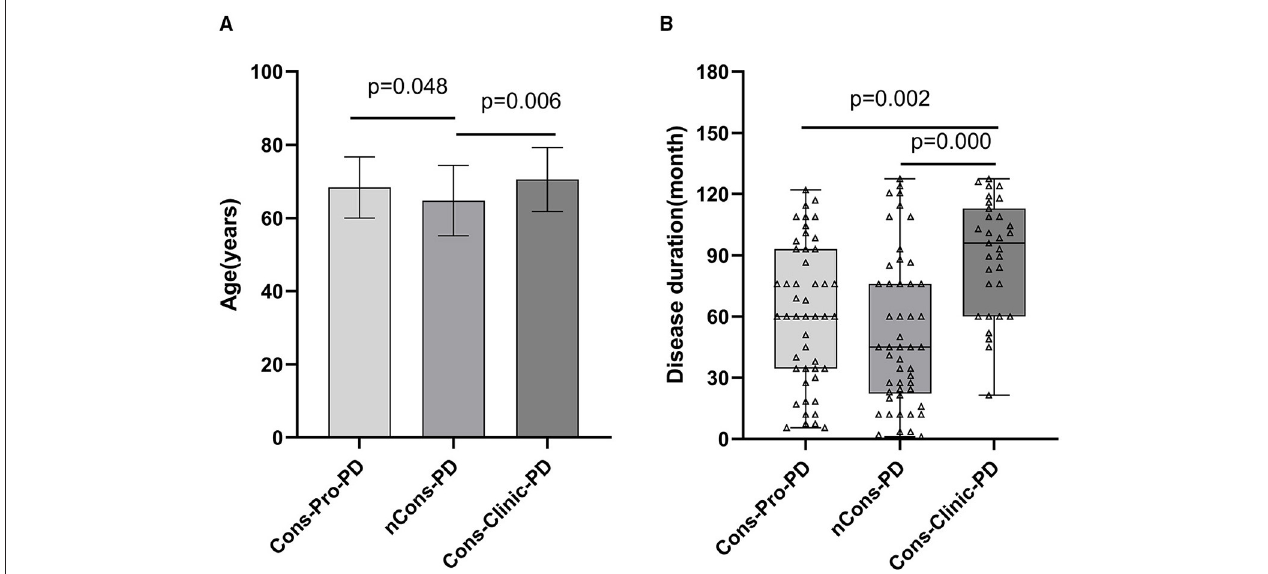
FIGURE 1 | (A) compares the ages of the three groups pairwise. The mean age of the nCons-PD group was 64.73 years (SD 9.565, Range 43–82), which was less than that of the Cons-Pro-PD group 68.35 years (SD 8.353, range 49–82, p = 0.048) and Cons-Clinic-PD groups 70.52 years (SD8.733, range 51–87, p = 0.006), with no statistically significant difference between Cons-Pro-PD and Cons-Clinic-PD groups ( p > 0.05). (B) shows that the median course of disease in the Cons-Clinic-PD group (M 88 months, QR 48–125) was longer than that of the Cons-Pro-PD group (M 48 months, QR 24–84, p = 0.002) and the nCons-PD group (36 months, QR 15.5–60, p = 0.000), but there was no significant difference in the course of disease between the Cons-pro-PD and nCons-PD groups ( p > 0.05).